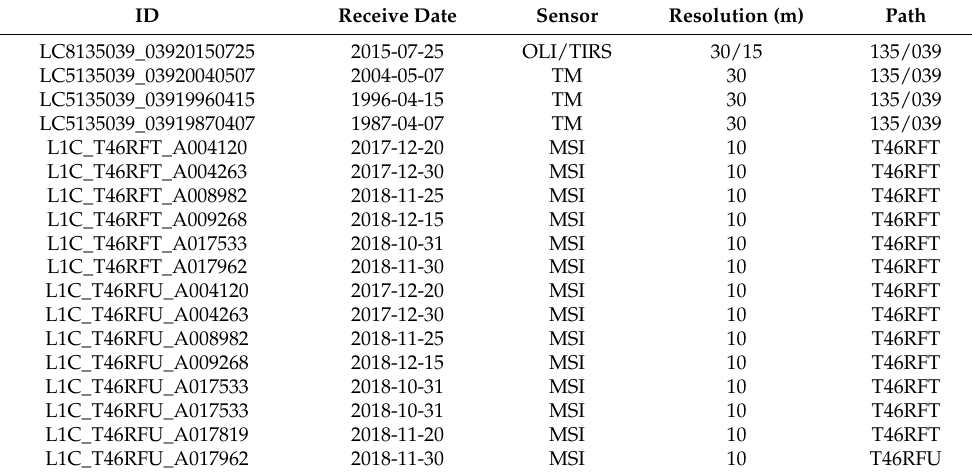
Table 1. Remote sensing images of the Sedongpu glaciers used in this study.